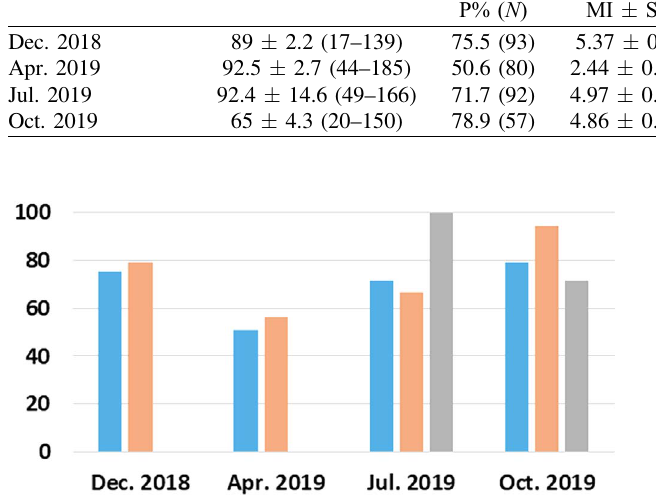
Figure 6. Prevalence of infection (%) of Coptodon guineensis at Sebkha Imlili. Blue bars = acanthocephalan Acanthogyrus ( Acan- thosentis ) cf. tilapiae (December 2018: n = 93; April 2019: n = 80;